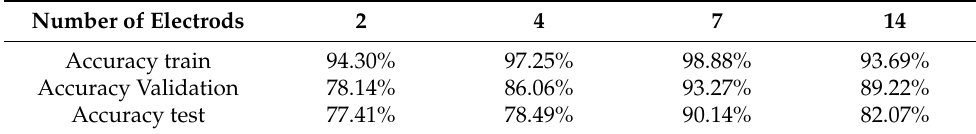
Table 8. Training, validation and testing accuracy of the various numbers of electrodes with DA.